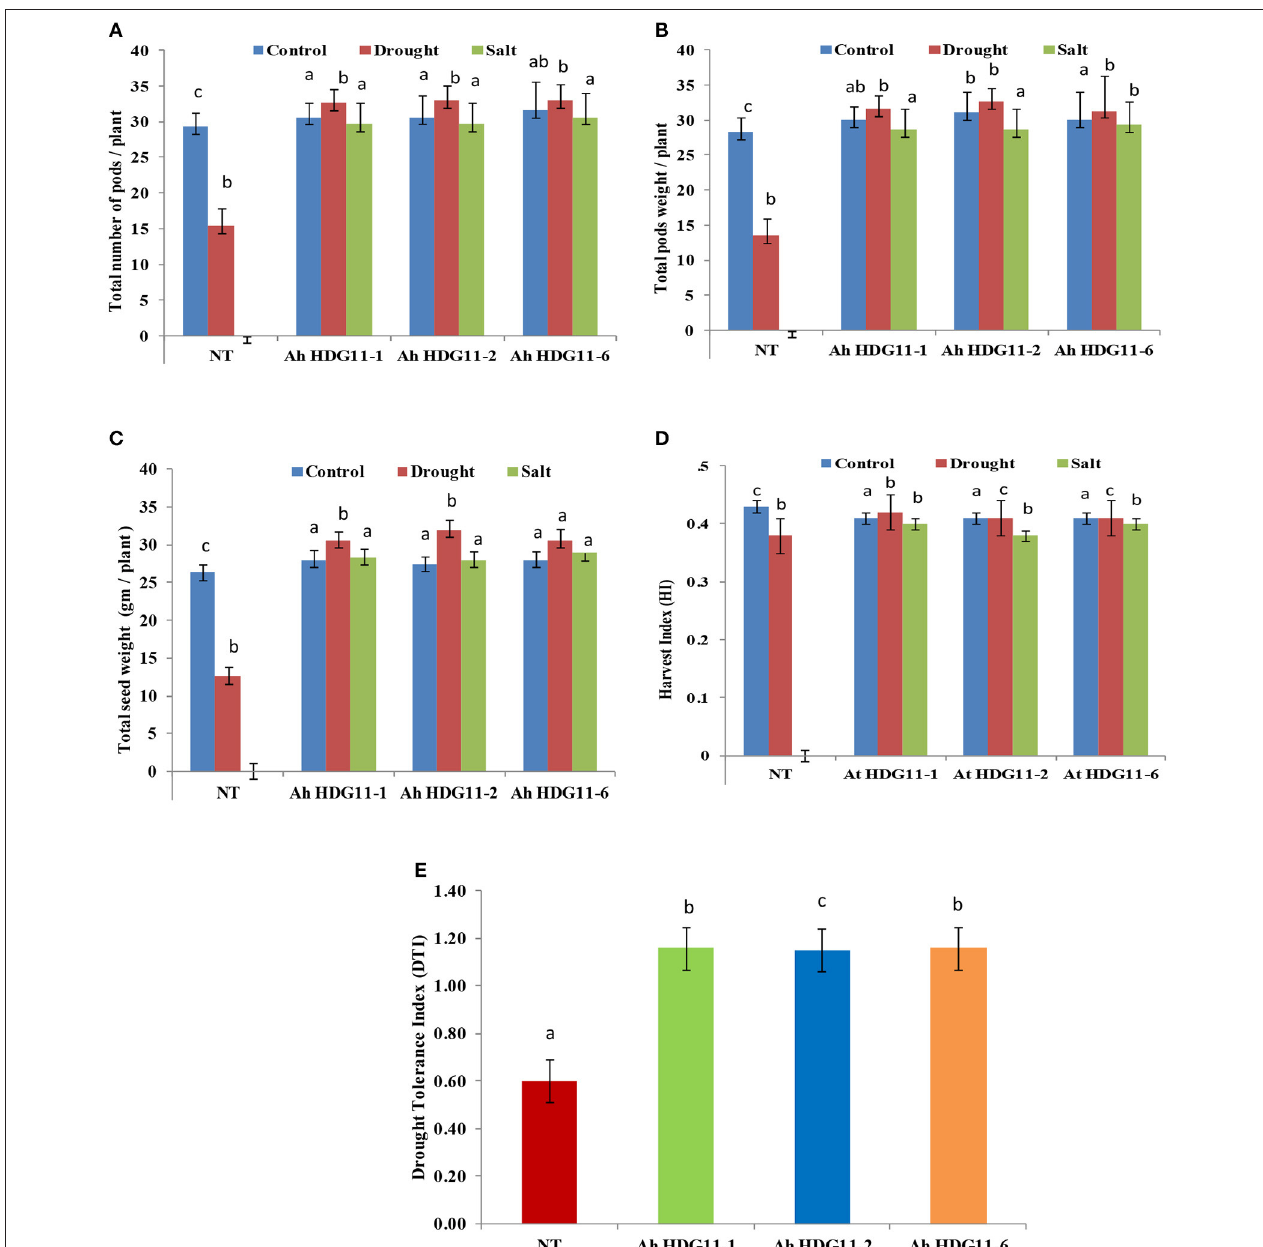
FIGURE 3 | Yield analysis of three transgenic lines AhHDG11-1, AhHDG11-2, AhHDG11-6 along with the control untransformed parent JL-24 (NT) under control (well-watered), drought, and salt stress from the confined outdoor lysimetric experiment. (A) Total number of matured pods/plant. (B) Pod weight (gm/plant). (C) Seed weight (gm/plant). (D) Harvest index. ( E) Drought Tolerance Index (DTI). Alphabets in lowercase indicates the statistical significance in differences between WT and transgenics at p < 0.05. non-transgenic plants ( Figure 6B ). As a result transgenic plants recorded higher WUE rates under both drought and salt